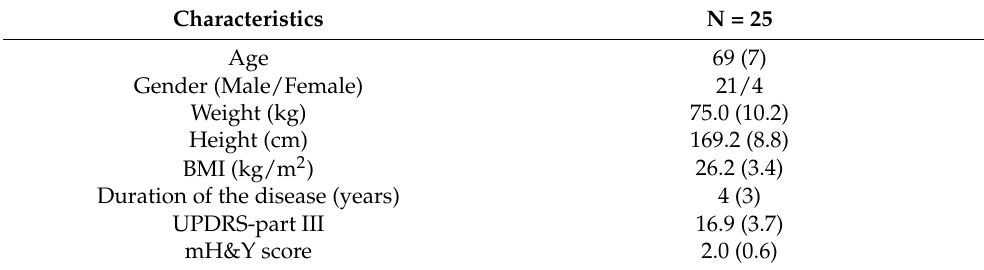
Table 1. Sociodemographic and clinical characteristics of the participants. Characteristics